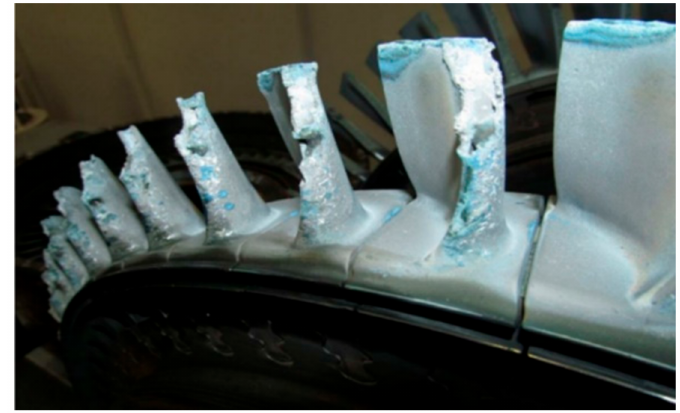
Figure 13. Consumption of the turbine material during internal object damage (IOD) events at high